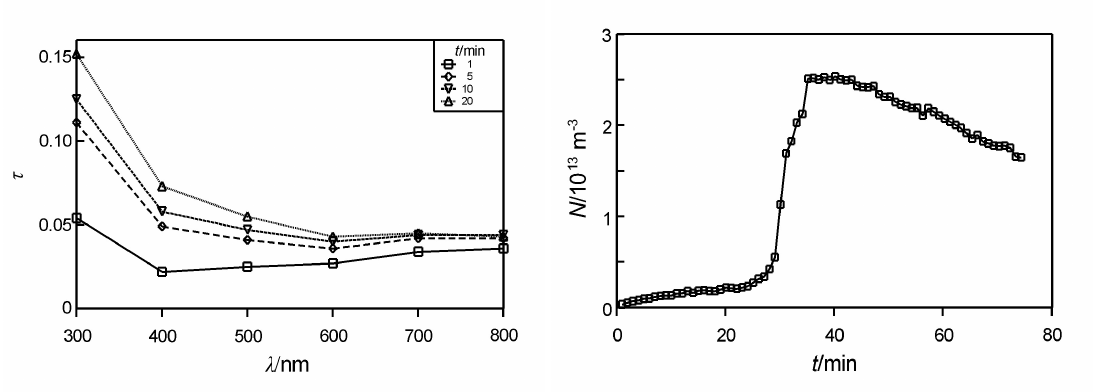
Figure 2. Measured turbidities and particle number variation for 0.30 mL A and 0.10 mL